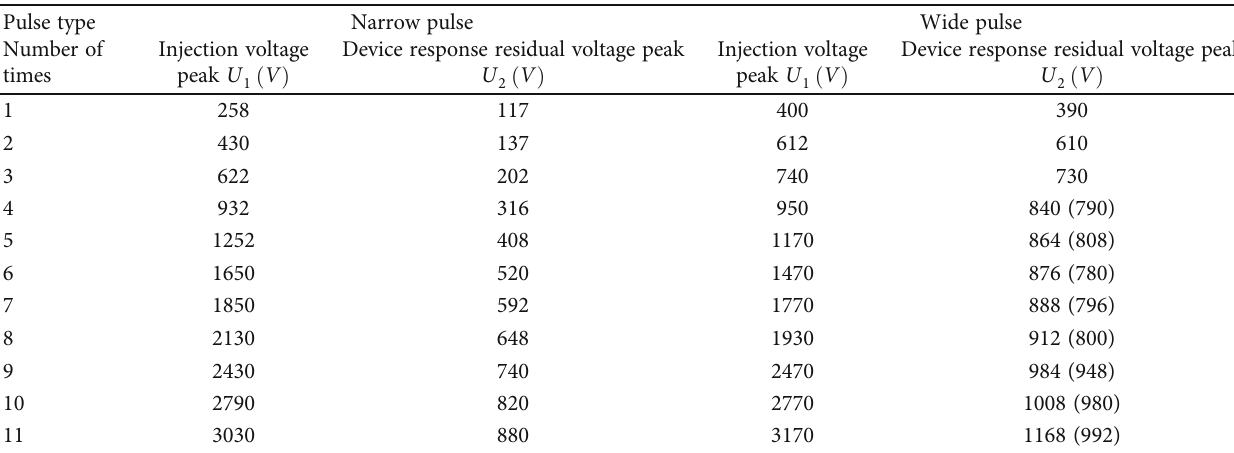
Figure 5: Device initial response voltage curve corresponding to di ff erent pulse rise times. Table 4: Test results of MOV ’ s ability to suppress electromagnetic